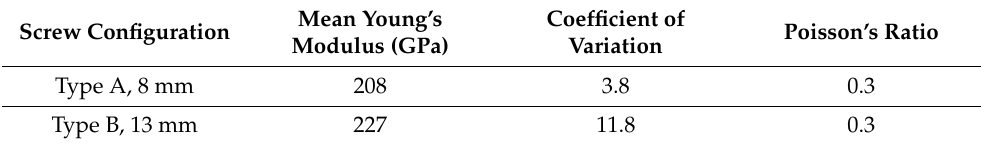
Table 7. Self-tapping screw material properties (from Screw Tensile Tests).